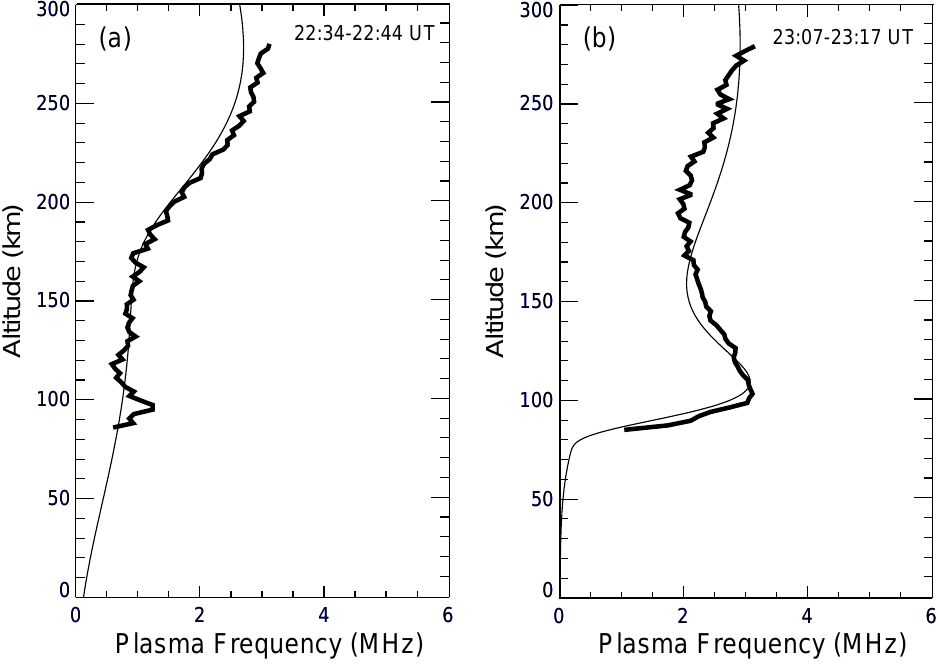
Fig. 6. Ionospheric plasma frequency profiles, derived from the EISCAT VHF beam 2. The data are indicated by the bold lines, and fitted double Chapman layers are indicated by the thin lines. (a) A profile typical of conditions prior to the substorm expansion phase onset (averaged between 22:34 and 22:44UT). (b) A profile typical of conditions during the expansion phase (averaged between 23:07 and